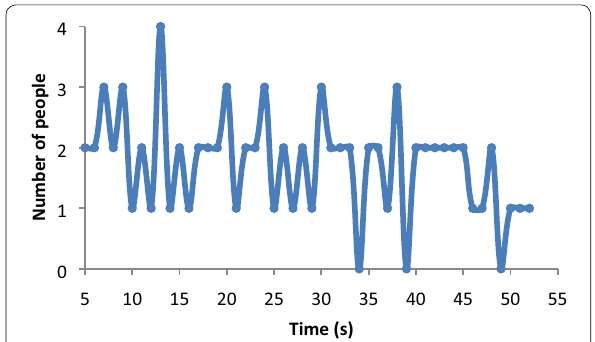
Figure 3 Flow rate time series of the real